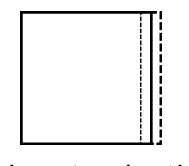
Figure 6. Deformation of verifying